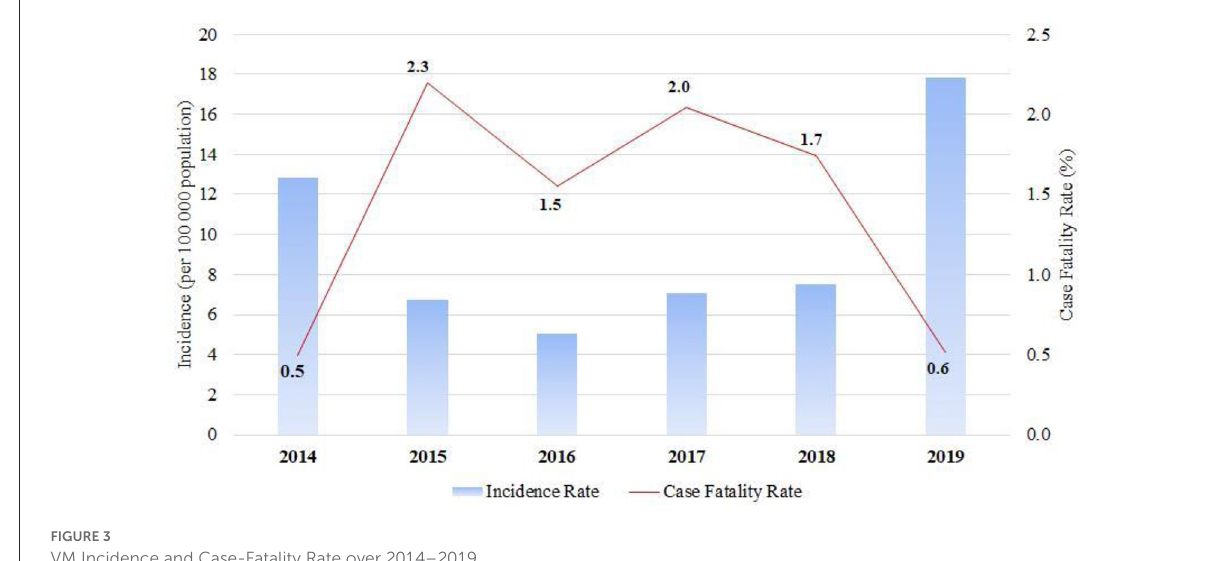
FIGURE3 VM Incidence and Case-Fatality Rate over 2014–2019.